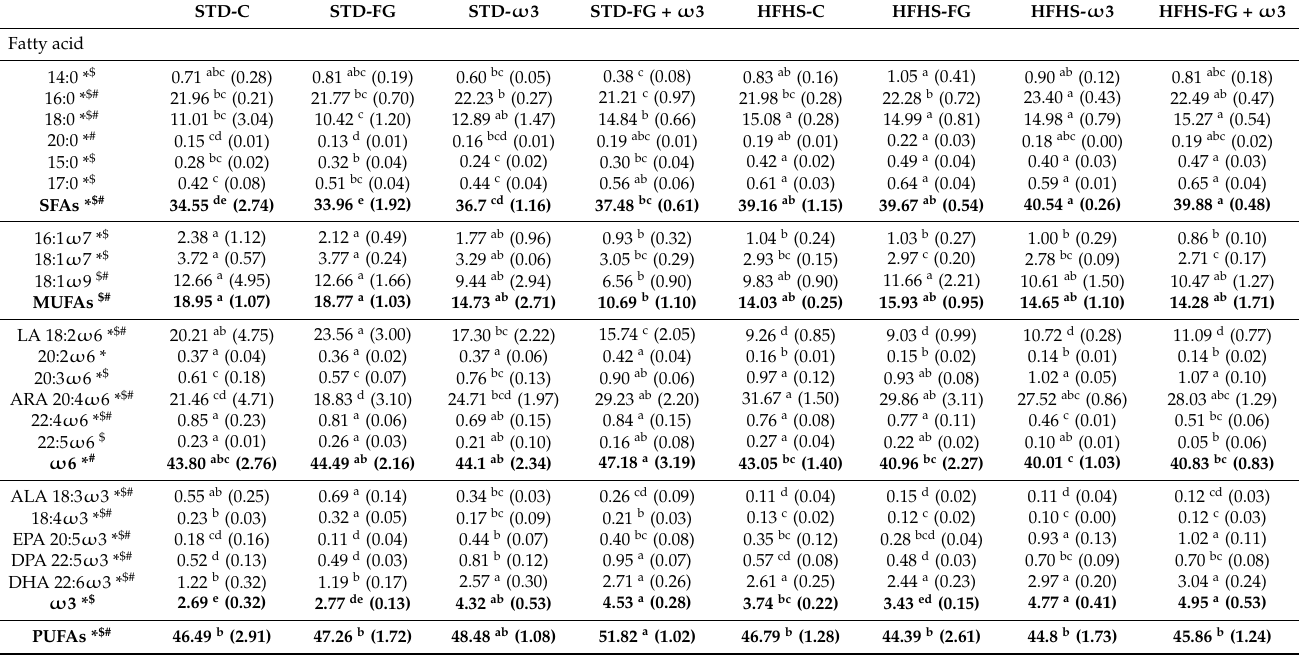
Table 2. Fatty acids composition of kidneys (mg/100 mg of total fatty acids) 1